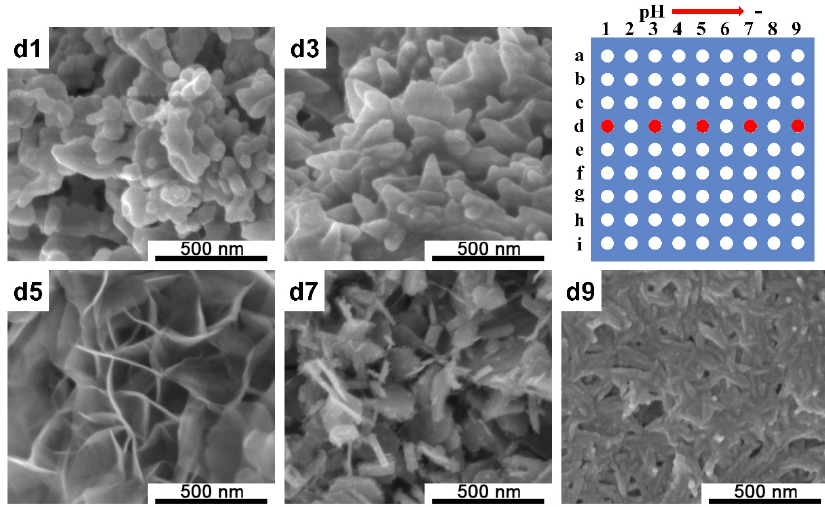
Figure 2. SEM images of calcium phosphate (CaP) structures observed in the screening platform and a schematic of the microreactors array. From d1 to d9, the pH values varied from 13 to 7. The red spots correspond to the positions of the precipitated samples of SEM acquisition.